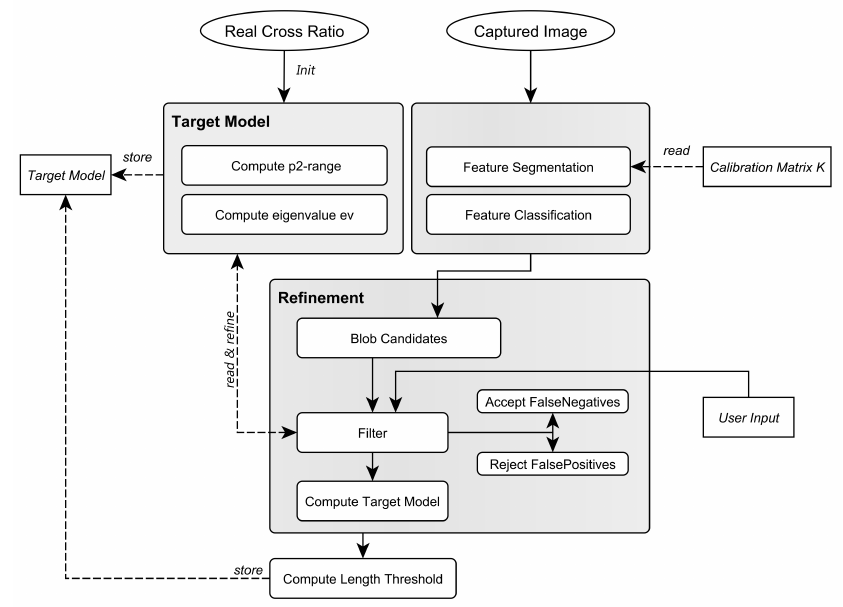
Figure 8. Pipeline to obtain the target’s